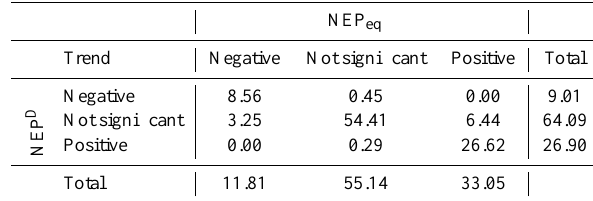
Table 5. Percentage of positive, negative and non-significant trends in NEP eq and NEP D for the Iberian